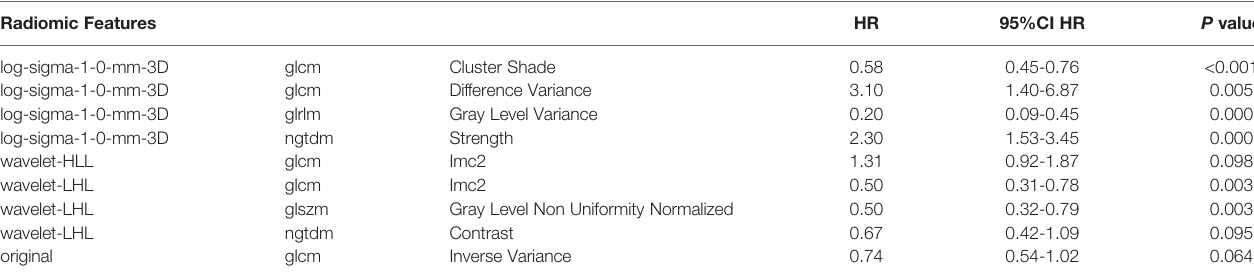
TABLE 2 | Stepwise COX regression predicting the PFS of the second-line osimertinib treatment. Radiomic